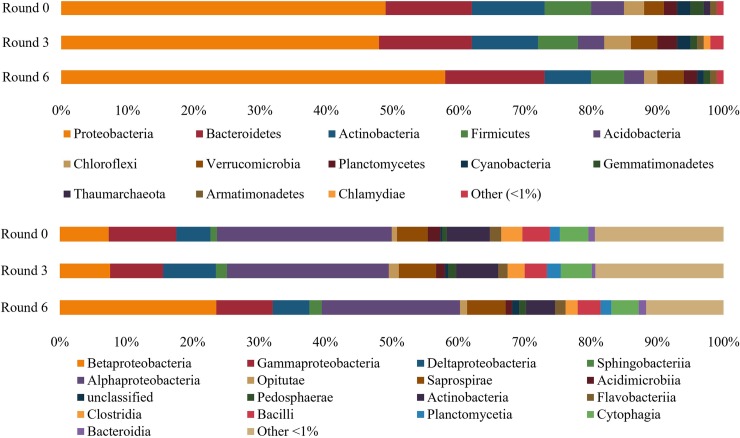
Taxonomic analysis.Stacked bar charts presenting relative abundance of each taxa at the phylum level (top) and class level (bottom). This comparison demonstrates host-mediated microbiome engineering (HMME) resulted in taxonomic increases in Proteobacteria and Betaproteobacteria in the community rhizosphere when comparing Round 0, 3 and 6 of HMME. Taxa were referenced to the 99% OTU Greengenes 13–8 database with a 1% abundance cutoff.